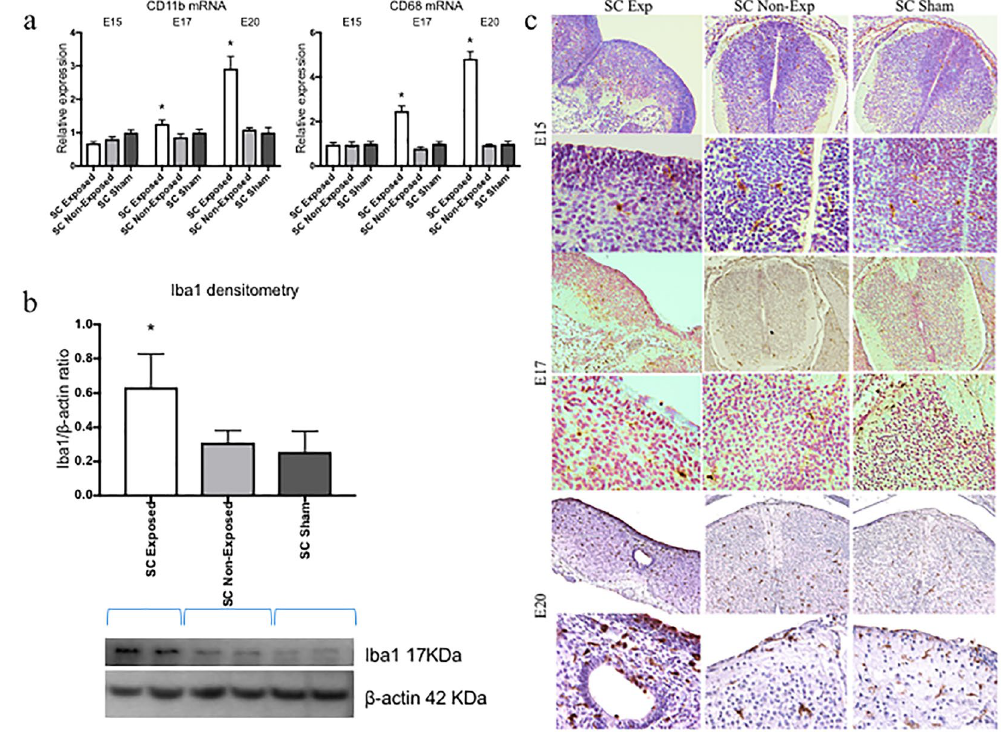
Figure 5. Immunofluorescence staining and quantification of microglia expression. ( a ) Comparison at E15, E17, and E20 for microglial markers CD11b and CD68 relative gene expression up-regulation in neural tissues of exposed and unexposed spina bifida and sham spinal cords. Values are means ± SE (6 fetuses/group) of relative mRNA expression (2 −ΔΔ Ct ) for RA-treated and the time-matched controls ( * p < 0.05) at E20 (n = 6). ( b ) Western blot results confirmed Iba1 protein expression increased in the exposed spinal cord for spina bifida compared with unexposed or sham spinal cords at E20 ( * p < 0.05). Data presented as means ± SD (6 fetuses/ group) of the densitometry ratio and representative cropped bands from the same gel Iba1 (17KDa) and β -actin (42 KDa). ( c ) Representative images of Iba1-immunoreactive microglial cells in spinal cord sections (10 × , 40 × ) at E15, E17 and E20 for exposed and unexposed spina bifida and sham spinal